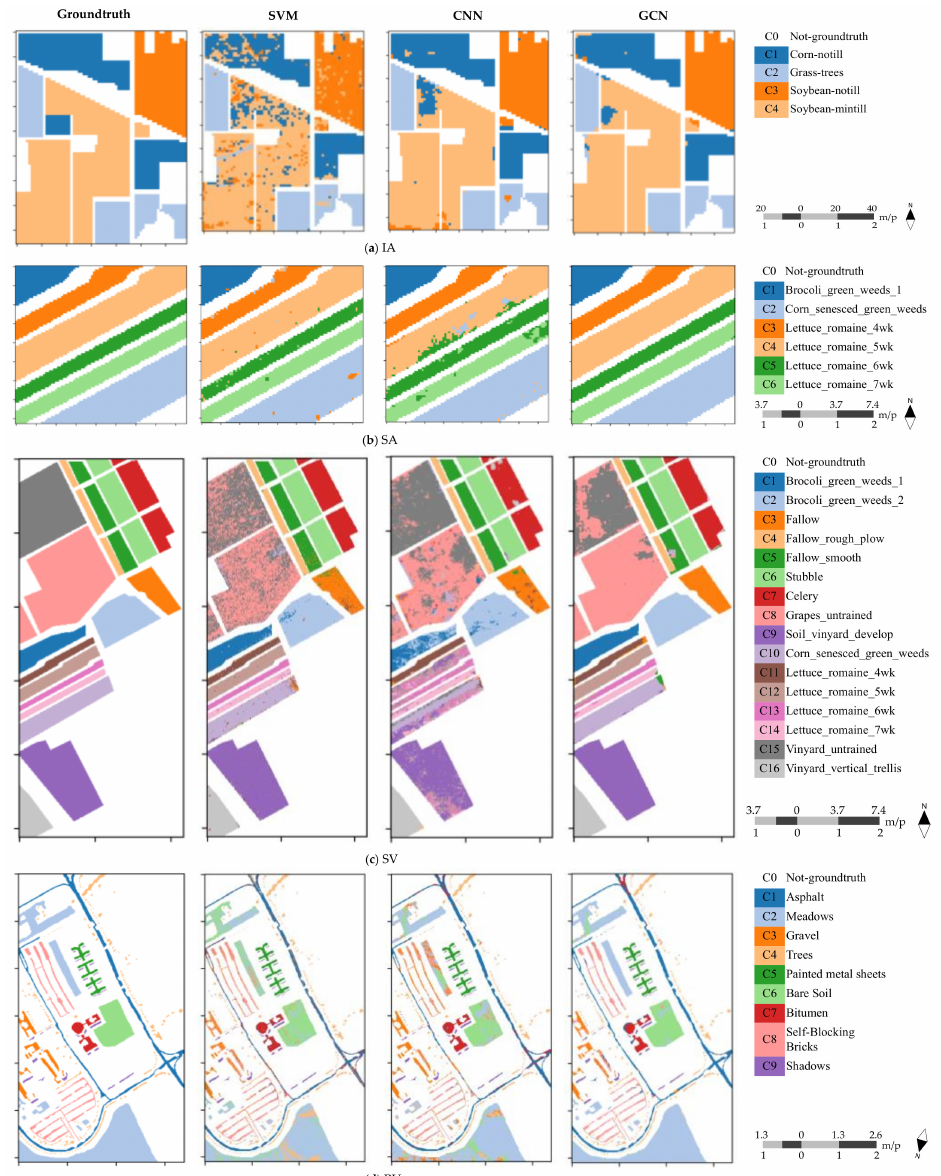
Figure 7. The classification maps of the presented GCN (the 4th column) and its competitors, i.e., SVM (the 2nd column) and CNN (the 3rd column), in the 1st run for four real hyperspectral datasets, i.e., ( a ) the IA dataset, ( b ) the SA dataset, ( c ) the SV dataset, ( d ) the PU dataset, corresponding to the experiment with five random